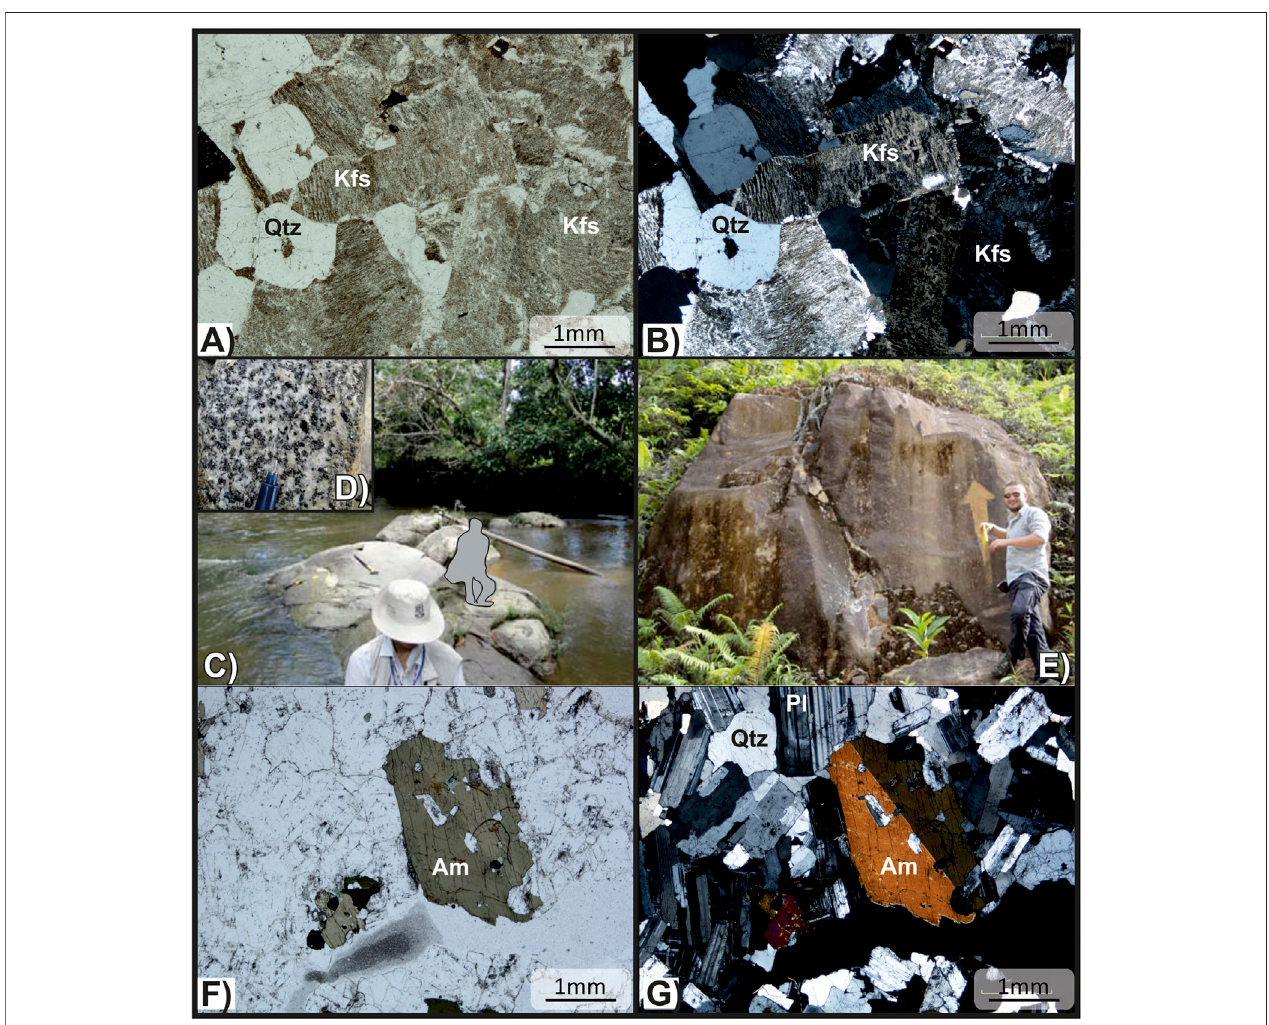
FIGURE11 | Representative fi eldphotographs and photomicrographsofintrusiverocks ofthe Schwaner Mountains. (A) and (B) Photomicrograph (PPL and XPL) oftheSangiyangGranite(DL10-075).Largealkalifeldspargrainscommonlyareexsolvedtomicroperthiteandshowadvancedsericitisation. (C) SepaukTonaliteoutcrop in river section (LD10-036). (D) Insert photograph shows a typical Sepauk Tonalite in hand specimen (LD10-100). (E) Outcrop of the Laur Granite (LD10-071). (F, G) Photomicrograph (PPL and XPL) of the Sepauk Tonalite (LD10-036), consisting predominantly of plagioclase, quartz and amphibole. Amphibole in the photomicrograph shows twinning and euhedral shape. (PPL — plane polarised light; XPL — cross-polarised light).